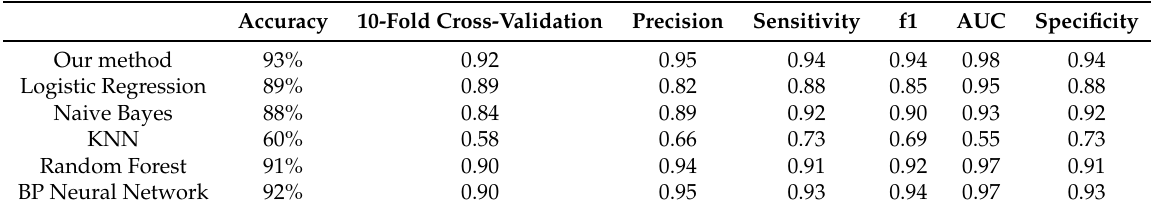
Table 4. Comparison of